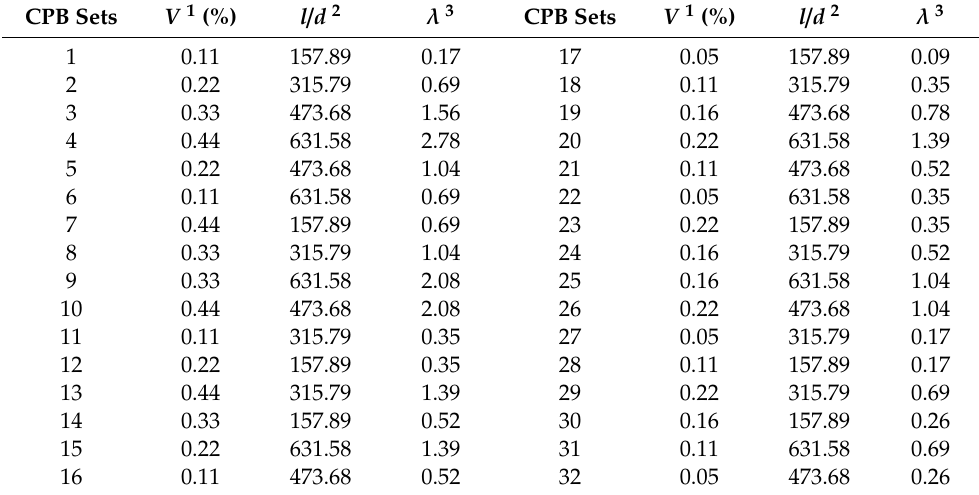
Table 5. Polypropylene (PP) fiber reinforcement index ( λ ).